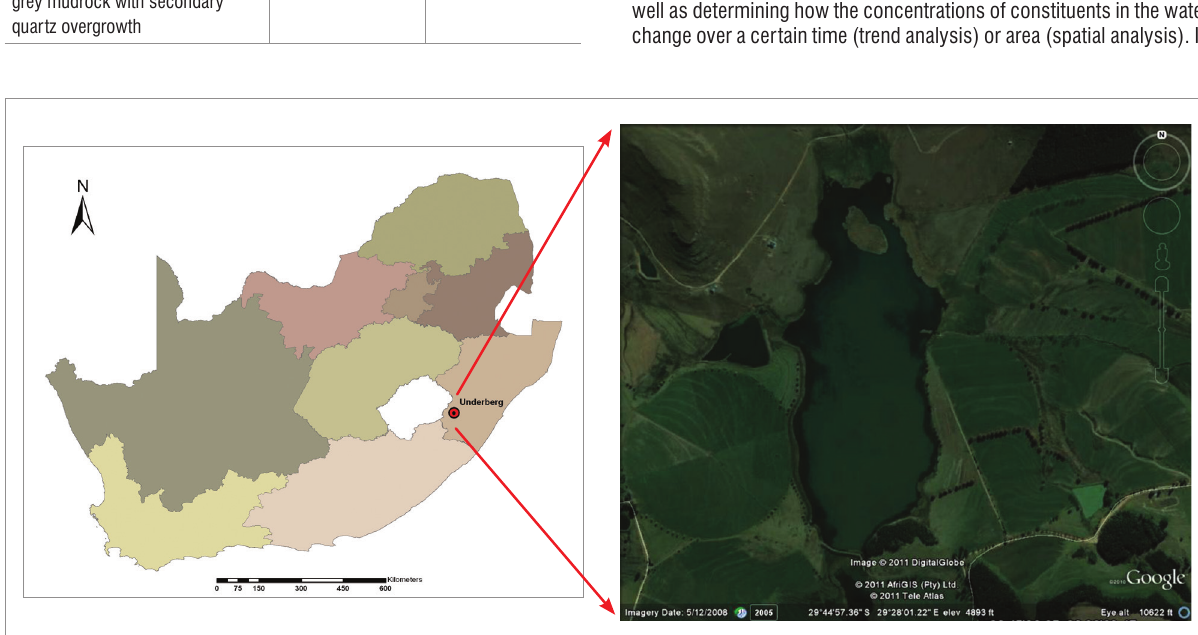
View of Bonsma Dam from the east, as seen from Cobham Road,